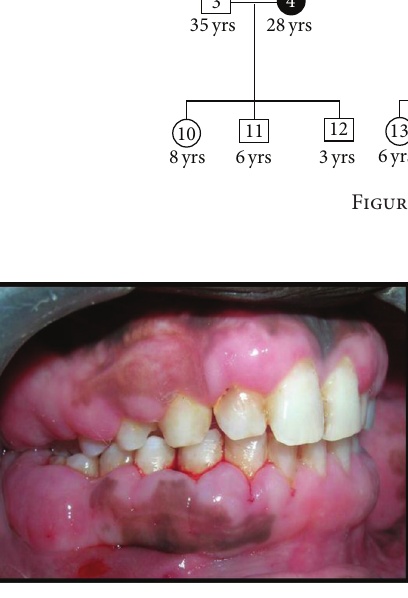
Figure7:Gingivoplastywasdoneandcontinuousslingsutureswere placed.